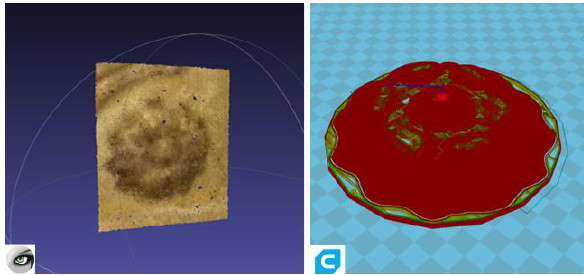
Figure 14. Creating mesh into MeshLab and check into CURA